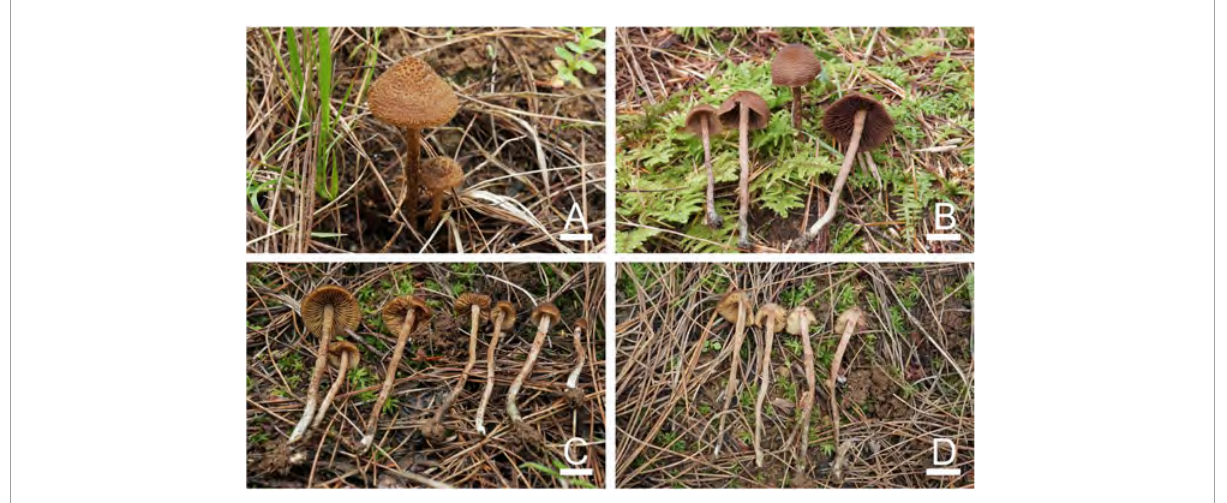
FIGURE10 Basidiomata of Inosperma squamulosohinnuleum . (A,C,D ) MHHNU32195, holotype and (B) MHHNU32362. Scale bars = 10